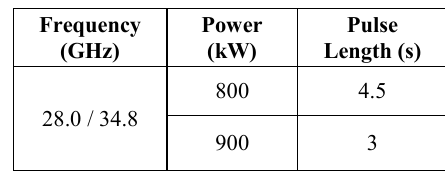
Table 2. Operating parameter combinations for the